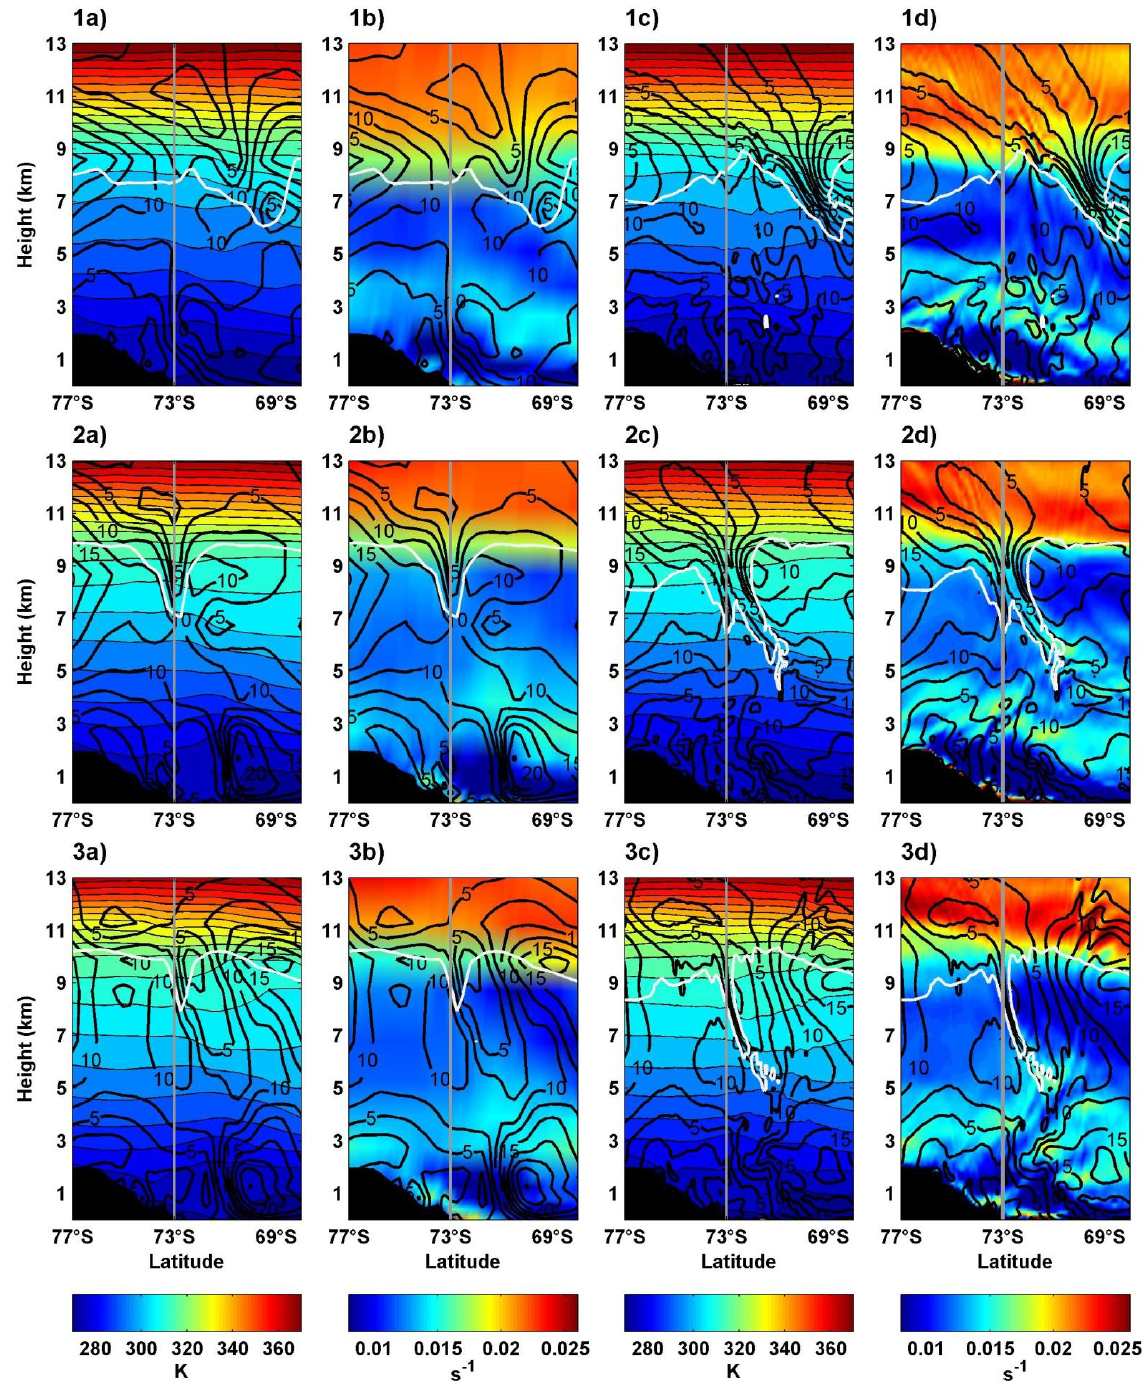
Fig. 5. Vertical cross-sections along 13.5 ◦ W (Fig. 2d). From 28 December 2010, 06:00UTC (1), 29 December 2010, 00:00UTC (2) and 29 December 2010, 12:00UTC (3) ECMWF model (a, b) and WRF model (c, d) . White line in all pictures represents the − 2pvu level of potential vorticity, vertical grey line is the location of MARA measurements, black lines show wind speed isotachs (ms − 1 ), colour bar scales in panels (a) and (c) show the potential temperature (K) and panels (b) and (d) buoyancy frequency (s − 1 ). WRF data are from the domain with 6km horizontal and 3h time